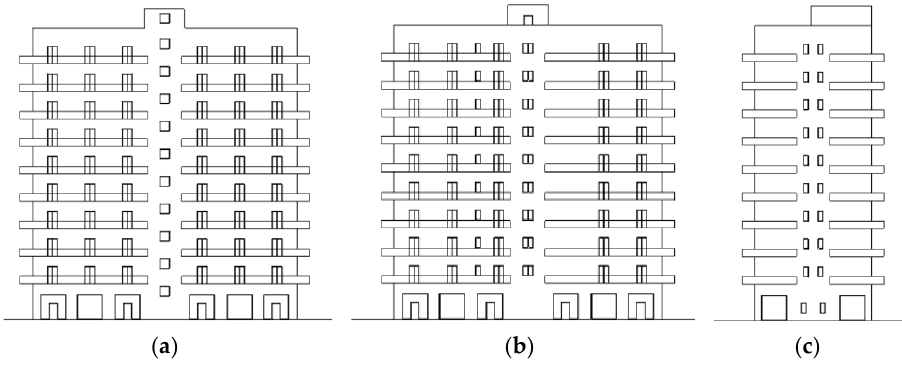
Figure 2. Architectural ( a ) front, ( b ) back and ( c ) lateral view.